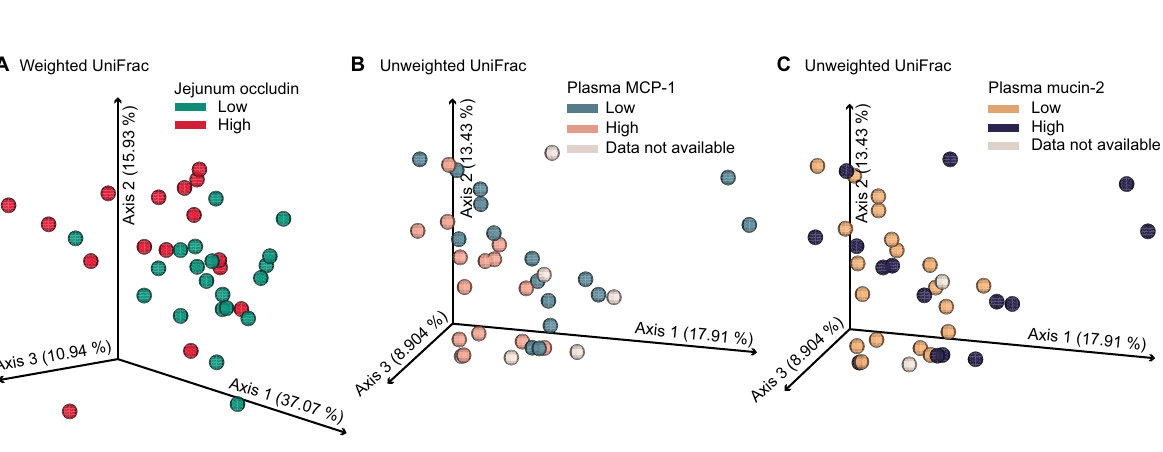
Figure 3. Alpha-diversity analysis with Pielou’s J’ , a metric of evenness, against various cytokines and chemokines localized to the intestinal region using (A) Pearson’s correlations with jejunum complement component 5a concentration (C5a, ng/ml) against number of distinct features, and (B) Kruskal–Wallis rank- sum tests with post hoc pairwise Mann–Whitney U tests with jejunum interleukin-6 concentration (IL-6, pg/ ml) and (C) colon C5a concentration (ng/ml) against Pielou’s J’ . The bottoms and tops of boxes indicate the first and third quartiles, respectively; whiskers indicate the 1.5 interquartile range beyond the upper and lower quartiles. Values outside the whiskers are indicated by gray circles; numbers in each box indicate sample sizes. Statistical significance in each categorical variable was evaluated using Kruskal–Wallis rank-sum tests with post hoc pairwise Mann–Whitney U tests at p < 0.05. * p < 0.05. C5a complement component 5a, IL-6 interleukin 6.